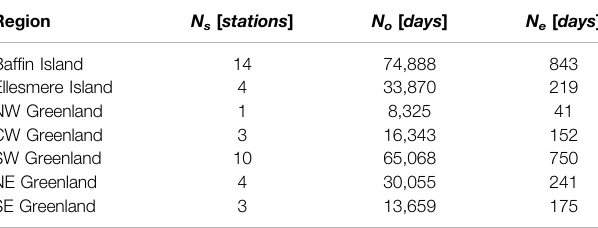
TABLE 1 | Number of stations ( N s ), observations ( N o ), and extreme events ( N e ) within each subregion. Region